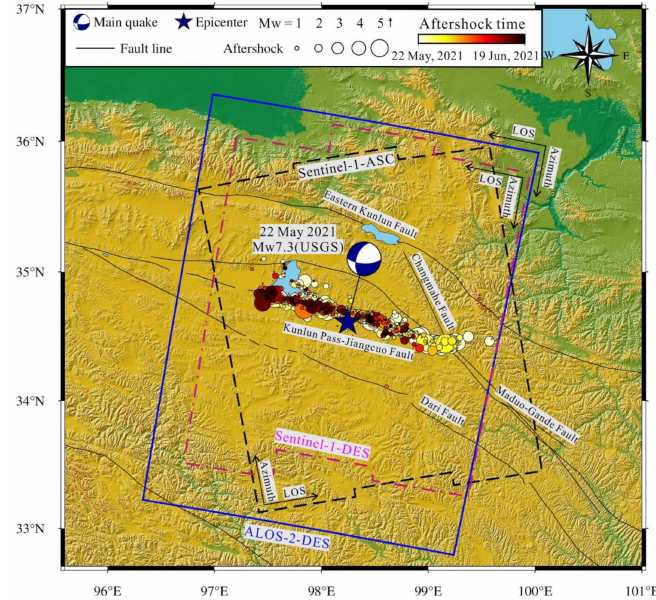
Figure 2. SAR image coverage and fault distribution in the seismic zone of the 2021 Maduo earth- quake. Black, brown, and blue polygons indicate the coverage of the Sentinel-1 ascending (ASC), descending (DES), and ALOS-2 descending (DES) orbital tracks SAR images. Black lines denote the fault surface traces in the seismic zone, and the blue star indicates the epicenter of the 2021 Maduo earthquake. The color balls indicate the aftershocks, whose original times are denoted by the color of the ball (see the color